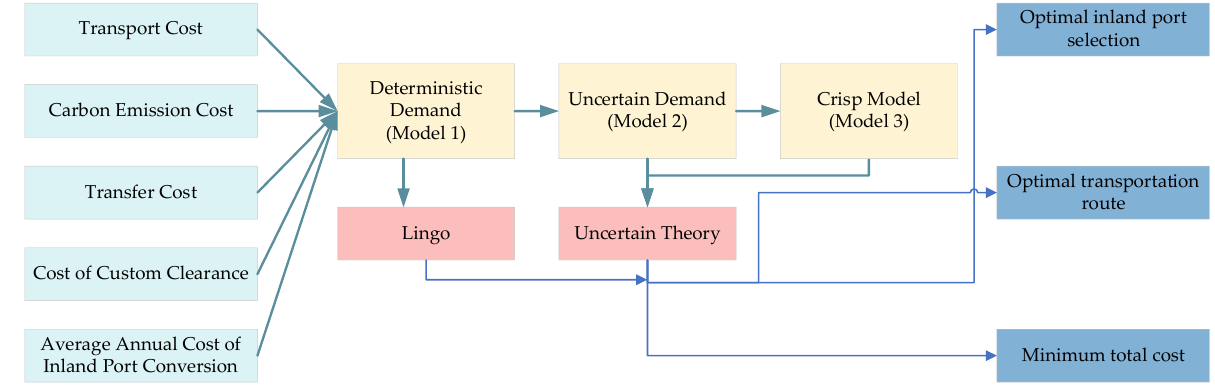
Figure 1. A schematic diagram of the stated work.